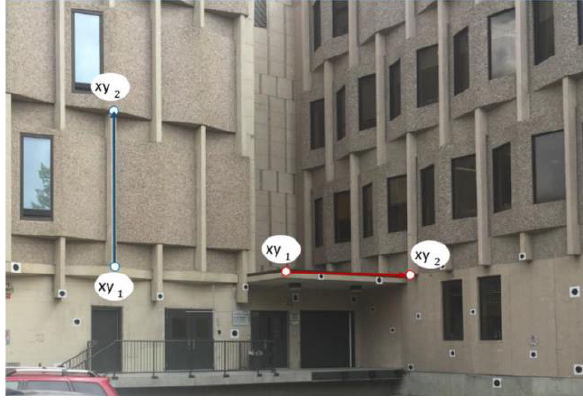
Figure 6. Straight Linear Feature Constraints